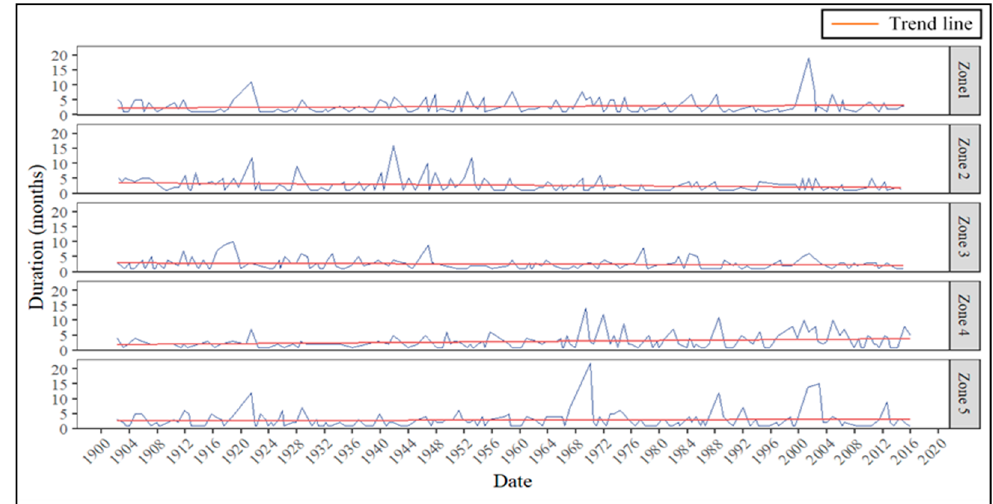
Figure 14. Three-month SPEI from 1902–2015 for zone 5.